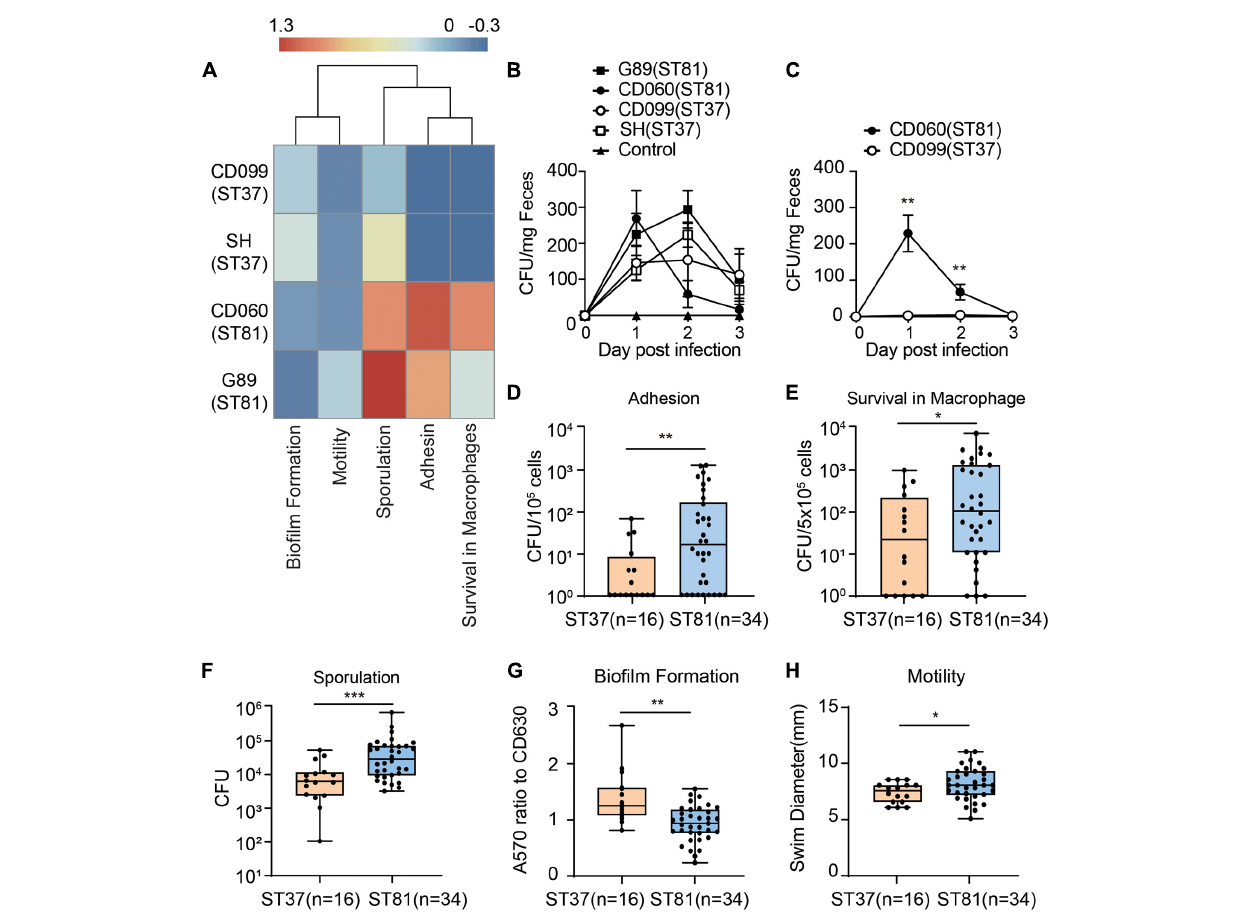
FIGURE 4 | Phenotypic characterization of the ST81 and ST37 isolates. (A) Phenotypic profiles of the four sequenced isolates compared to CD630. Results of different phenotypes were adjusted as follows: adhesion, survival from macrophage and sporulation data were calculated as logCFU (isolate)-logCFU (CD630); biofilm and motility data were calculated as a ratio (isolate-CD630)/CD630. The heatmap was generated by setting enhanced phenotype ( > 0) and decreased phenotype ( < 0). The colors from blue to red represent the degree of difference. (B,C) Stool samples from mice infected with various isolates (B) or competitive assays (C) were collected from day 0 to day 3 post infection and subjected to C. difficile culturing. Colonies were counted and quantified per milligram of fecal samples. (D–H) Colony counts of clinical C. difficile isolates adhered to Caco-2 cells (D) , survival in THP-1 cells (E) , and spore production (F) . (G) Biomass was measured by the absorbance at 570 nm and normalized to CD630. (H) Swim diameters were recorded to assess the motility. Data are shown as min to max. All experiments were repeated at least three times independently. Significant differences are indicated with * p < 0.05, ** p < 0.01,*** p <